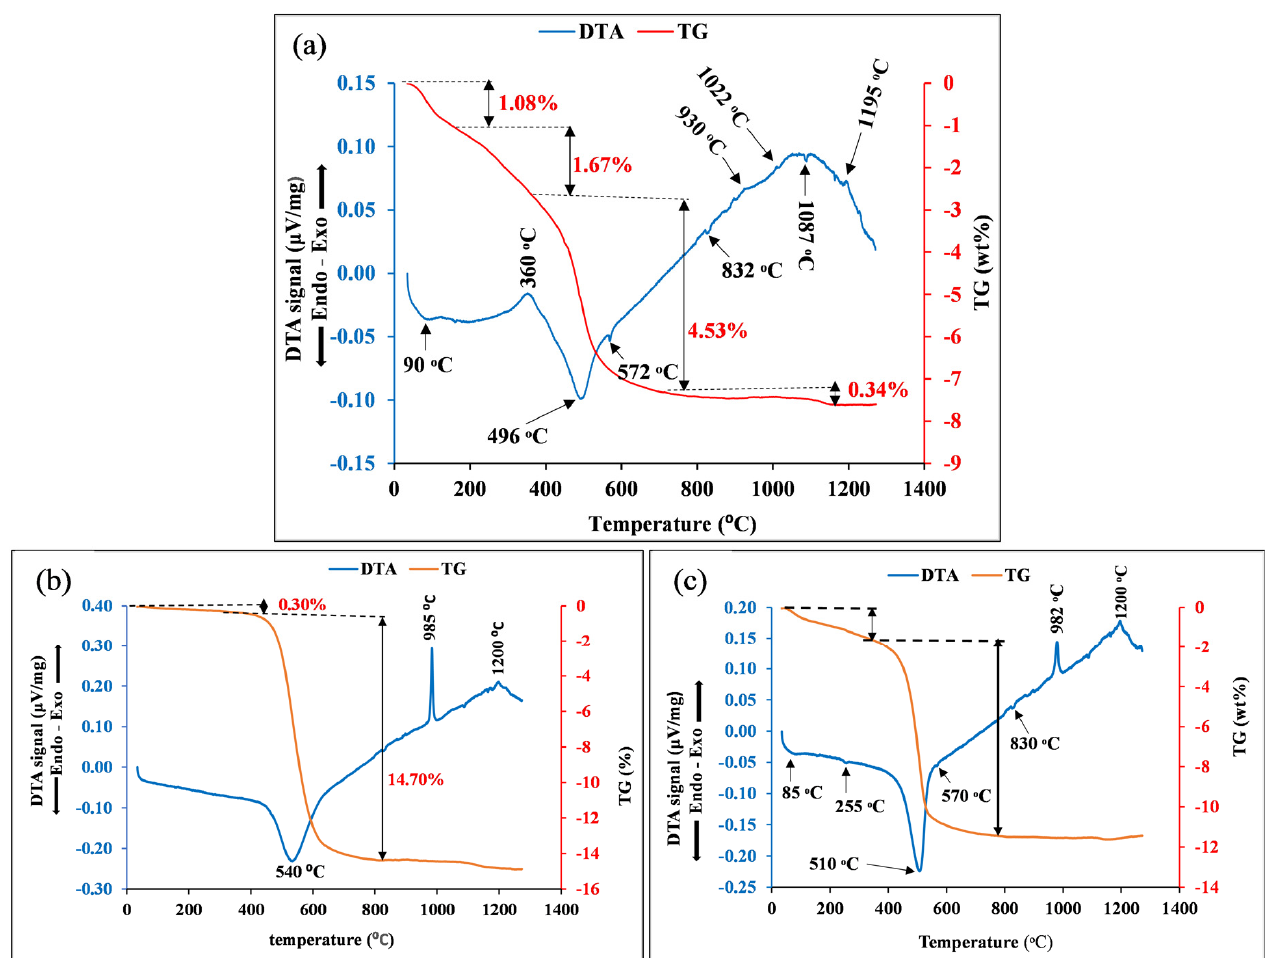
Figure 4. Differential thermal analysis (DTA) and thermogravimetry (TG) curves of ( a ) KORS, ( b ) KCR, and ( c ) HCR.